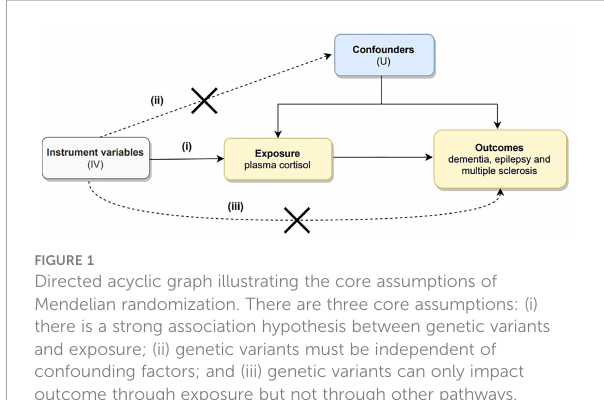
FIGURE 1 Directed acyclic graph illustrating the core assumptions of Mendelian randomization. There are three core assumptions: (i) there is a strong association hypothesis between genetic variants and exposure; (ii) genetic variants must be independent of confounding factors; and (iii) genetic variants can only impact outcome through exposure but not through other